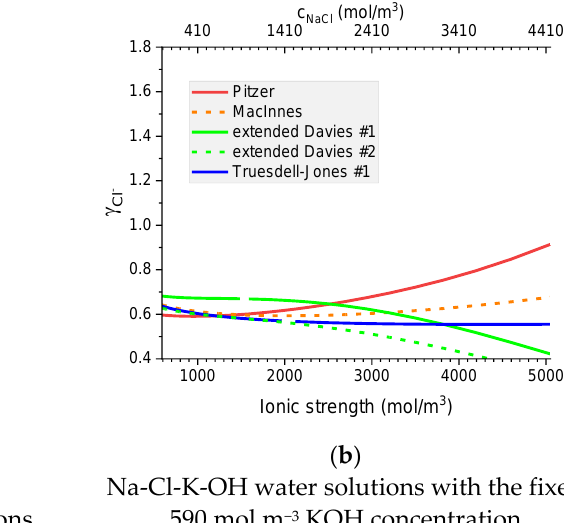
− in Na‑Cl‑K‑OH water solutions as a func‑ − 3 ; and NaOH concentration − 3 . Notations #1 and #2 correspond to different